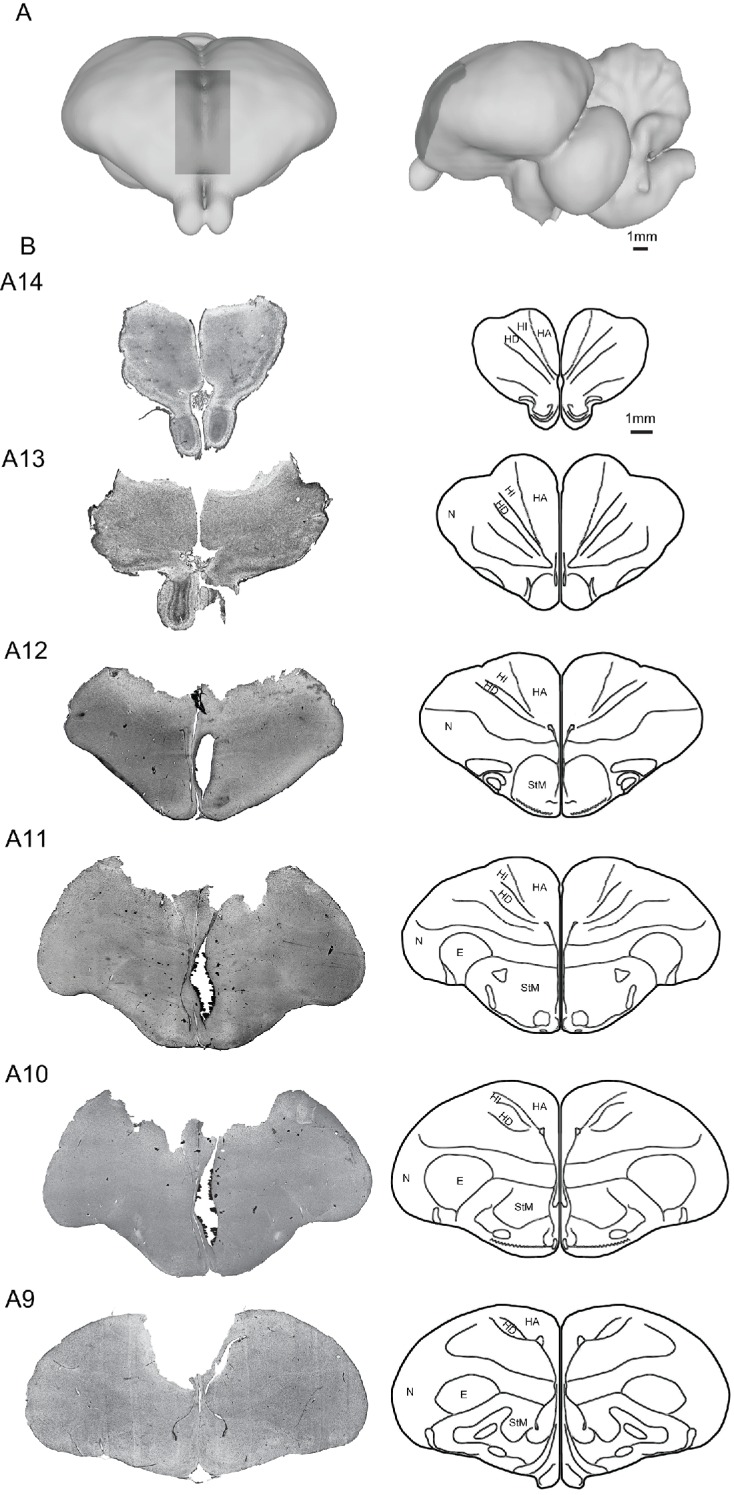
Locations of bilateral Wulst lesions in the pigeon brain.(A) Schematic diagram of the frontal (left) and lateral view (right) of the Wulst (dark gray: A8.00 to 14.50, 0 to L3.00, 0 to H3.00) in both hemispheres (Karten and Hodos, 1967). (B) Histograph of the frontal sections through the Wulst lesion areas (left) and corresponding schematic overviews (right) (Karten and Hodos, 1967). Abbreviations: E, entopallium; HA, hyperpallium apicale; HD, hyperpallium densocellulare; HI, hyperpallium intercalatum; N, nidopallium; StM, striatum mediale (Avian Brain Nomenclature Forum et al., 2004).